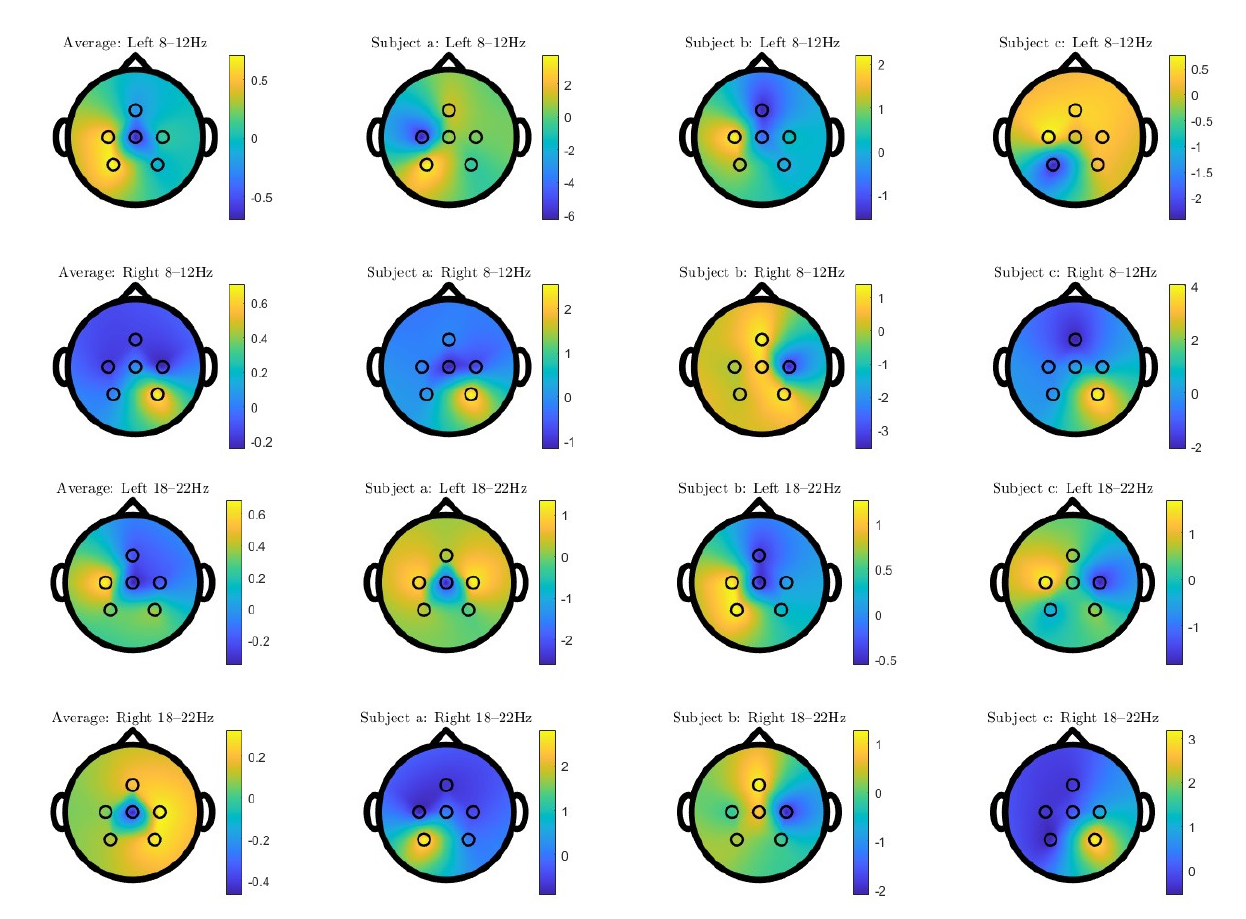
Figure 9. Spatial patterns corresponding to the 8–12 and 18–22 Hz bands (top 2 rows and bottom 2 rows), averaged for all participants (Average) and for 3 randomly selected subjects (subjects a, b, and c) (arranged columnwise), for imagined left-hand clenching ( Left ) and imagined right-hand clenching ( Right ) (arranged top and bottom row in each